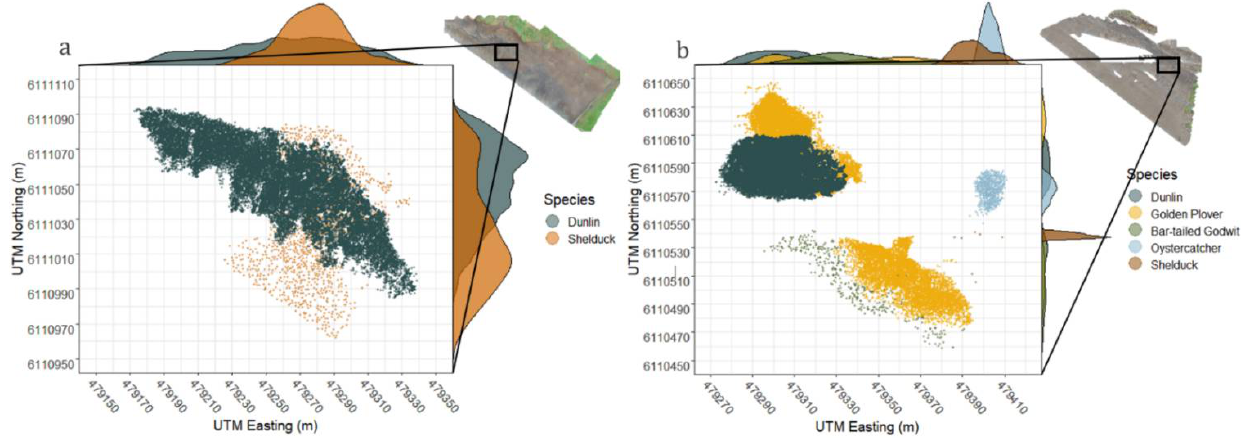
Figure 4. Orthomosaic excerpts from UAS fights with frequencies of density distribution. ( a ) Excerpt from 27 September and ( b ) excerpt form 23 October. The excerpts were projected in UTM metric coordinates. Both excepts contained multispecies distributions commonly encountered on the UAS-derived orthomosaics. On the y -axis and x -axis, frequency distributions are simulated, when observing the area from a ground perspective.